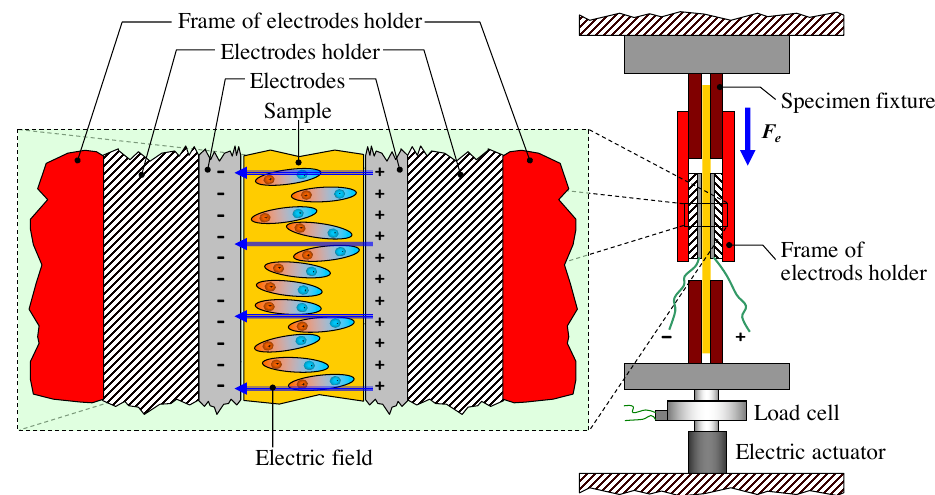
Figure 6. Uniaxial load test: the specimen (orange), inserted into the electrodes holder (dashed black and red), is held by two fixtures (dark red), which are kept at a fixed position. When an external electric field is applied, the specimen contracts and the load cell measures the contraction force F e